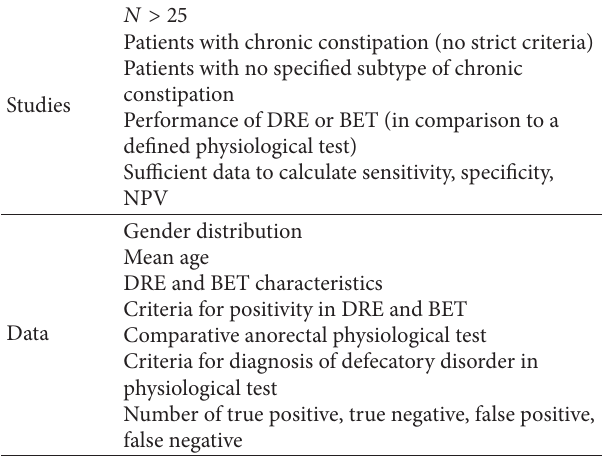
Table 1: Inclusion criteria and extracted